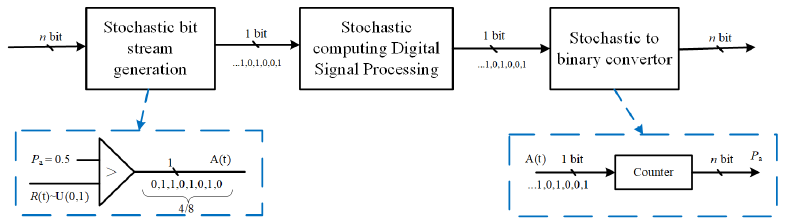
Figure 2. Typical-Stochastic-Computing-based DSP system [15].